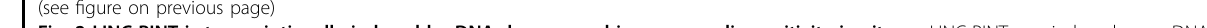
Fig. 2 LINC-PINT is transcriptionally induced by DNA damage and increases radiosensitivity in vitro. a LINC-PINT was induced upon DNA damage with different DNA-damaging agents. HNE1 cells were treated with the DNA-damaging agents: Eto (10 μ M), Bleo (1 μ g/ml), TMZ (125 μ M), and IR (8 Gy). LINC-PINT levels were measured by qRT-PCR. b Expression of LINC-PINT was determined by real-time RT-PCR after treating HNE1 cells with different DNA-damaging agents at different time points. RNA samples were analyzed by quantitative RT-PCR. c Representative images of clonogenic survival assay in HNE1 and HONE1 cells, which were transiently transfected with LINC-PINT overexpression plasmid or control plasmid, followed by a range of 0 – 8-Gy radiation doses. d It was shown that radiation survival curves were fi tted by a linear quadratic equation. Up, HNE1 cells; Bottom, HONE1 cells. e Flow-cytometry analysis was performed to detect cell apoptosis for NPC cells, which were transfected with LINC-PINT vectors or negative controls and exposed to different doses of radiation. f Quantitative analyses of cell apoptosis in HNE1 (up) and HONE1 (bottom). Data represent the mean ± SEM from three independent experiments ( a – f ). Statistical signi fi cance was calculated using a two-sided t test. * P < 0.05, ** P < 0.01, *** P <